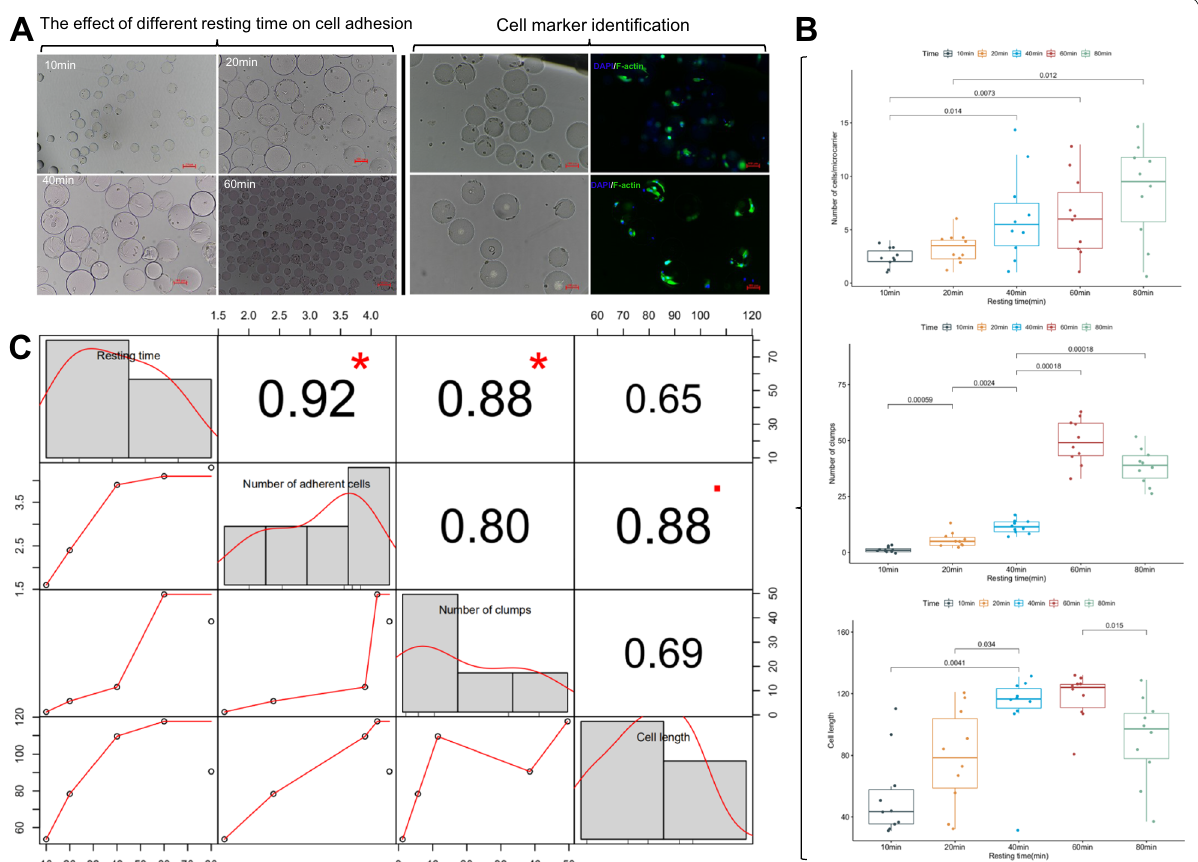
Fig. 3 Effect of different resting times on cell adhesion. A Cell attachment and morphological results. B Comparative analysis of the number of attached cells and produced clumps and the difference in cell length in the cell culture microenvironment at different resting times. C Multi-factor correlation analysis for resting time, number of attached cells, number of clumps, and length of